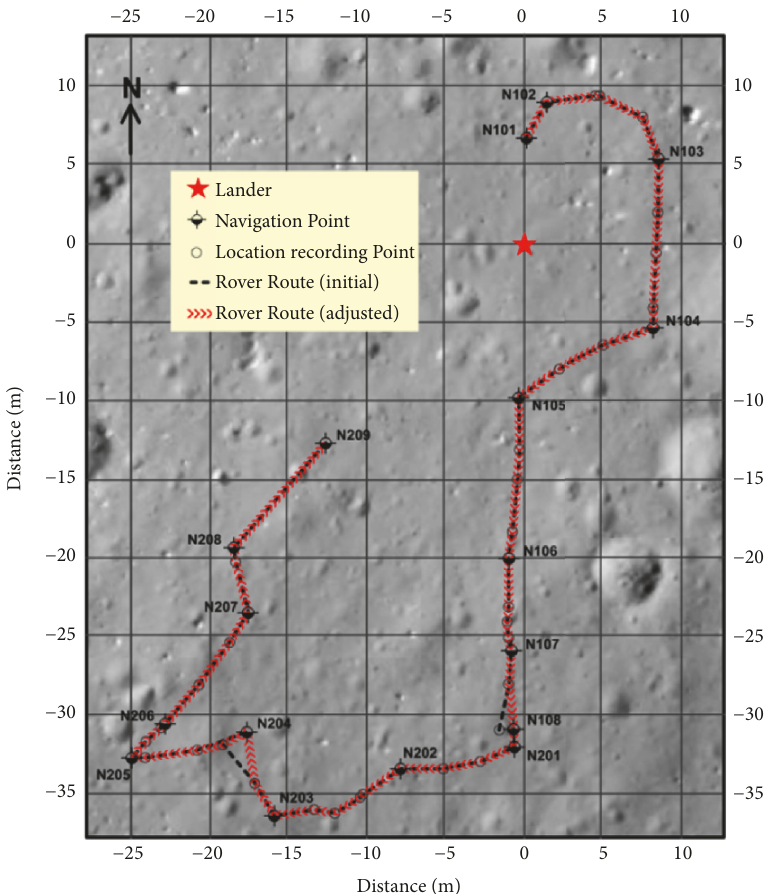
Figure 1: Yutu’s path on the Moon. The context image was taken by the descent camera on the CE-3 lander. Red star shows the landing site. The inset lines show the initial path (black dotted line) read directly from the LPR data and the adjusted path (red line).